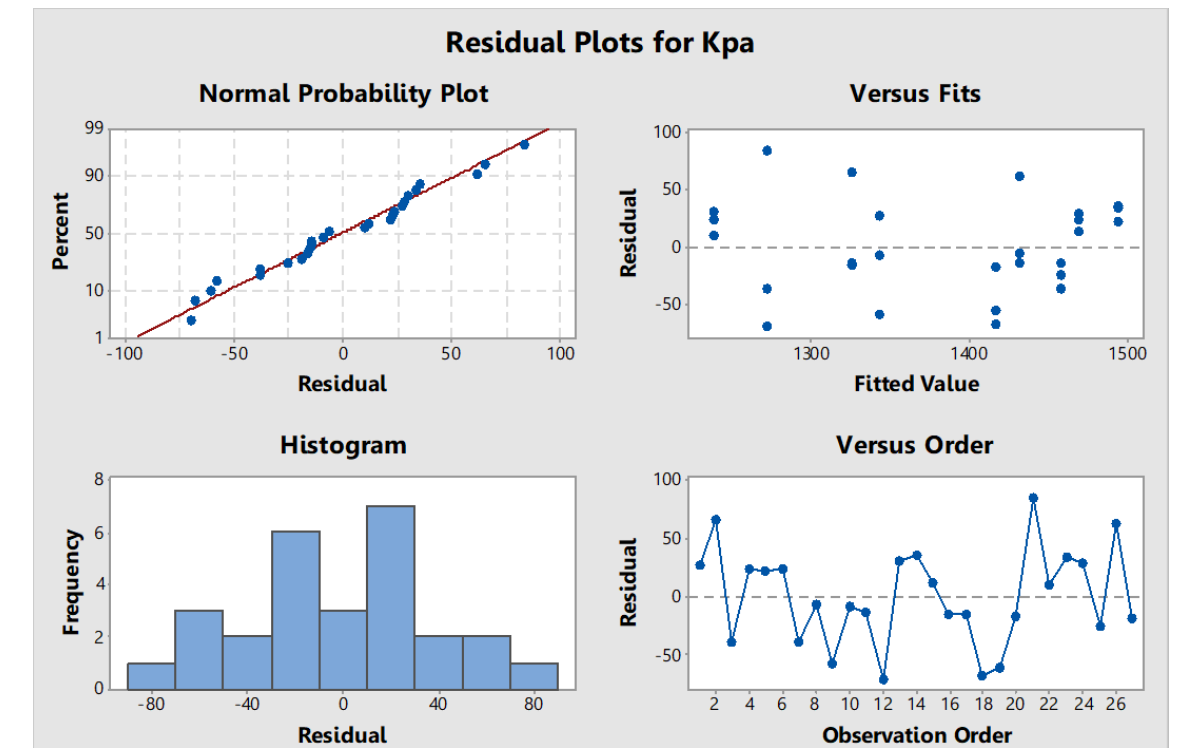
Figure 1. Residual plots for response average (kPa).